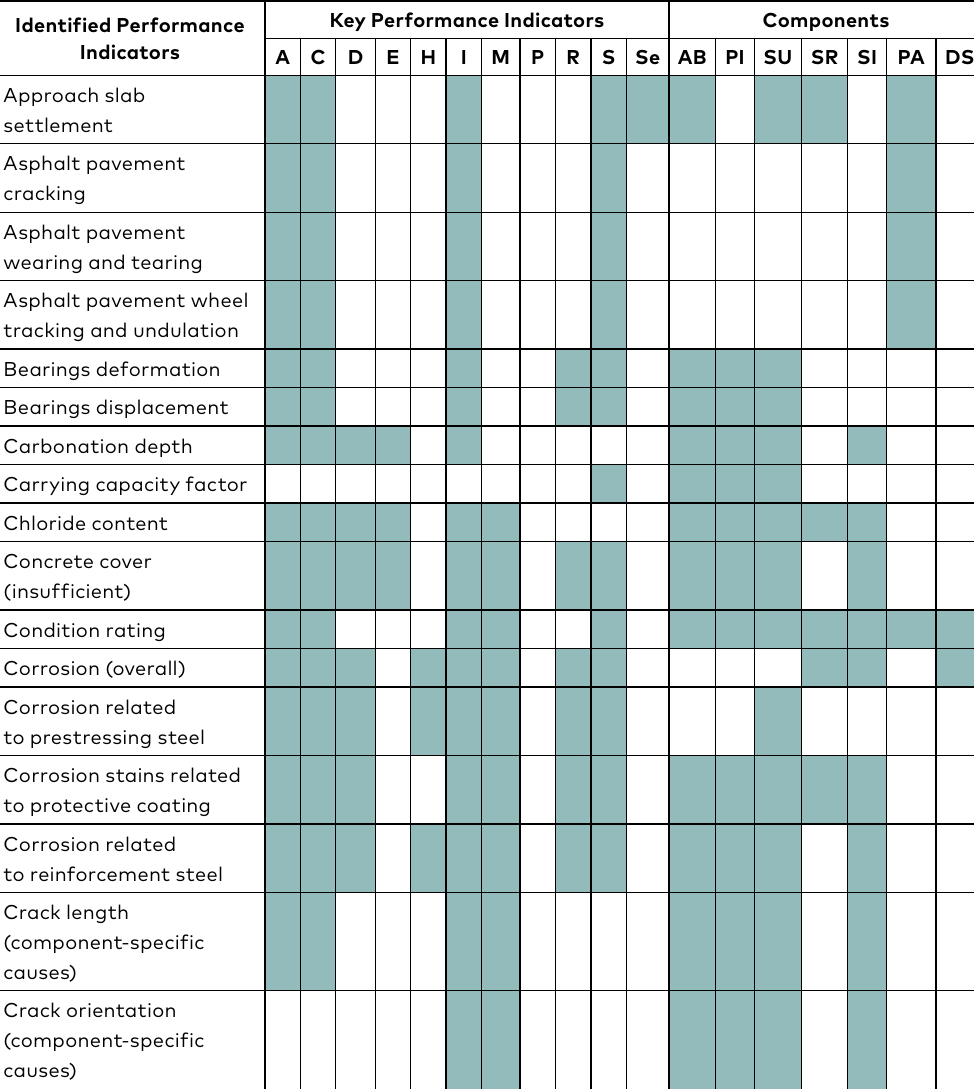
Table 2. Identified and discretized Performance Indicators for the Strimonas Bridge Identified